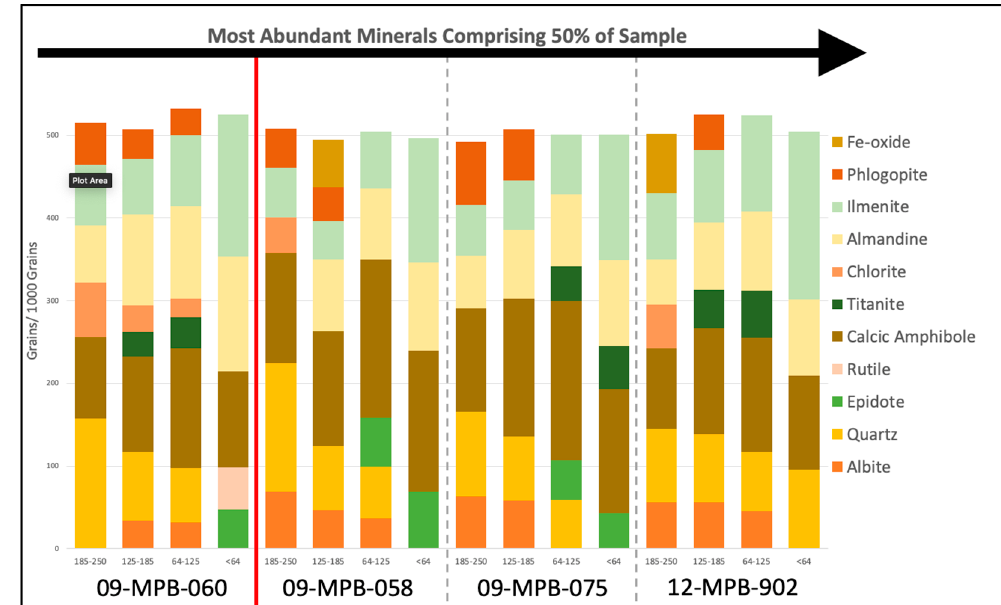
Figure 6. Mineral abundance (normalized to 1000 grains) for the most abundant minerals comprising 50% of <250 µm till heavy mineral concentrates, for four size fractions of four till samples. Red line denotes the relative position of massive sulfide mineralization, and the black arrow denotes the direction of ice flow.